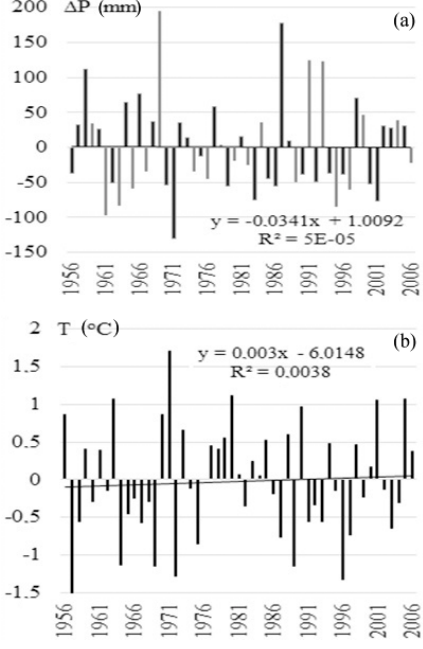
Figure 15. Deviation of annual temperature (a) and atmospheric precipitation (b) from the long-term average of the Vanch River basin for the period